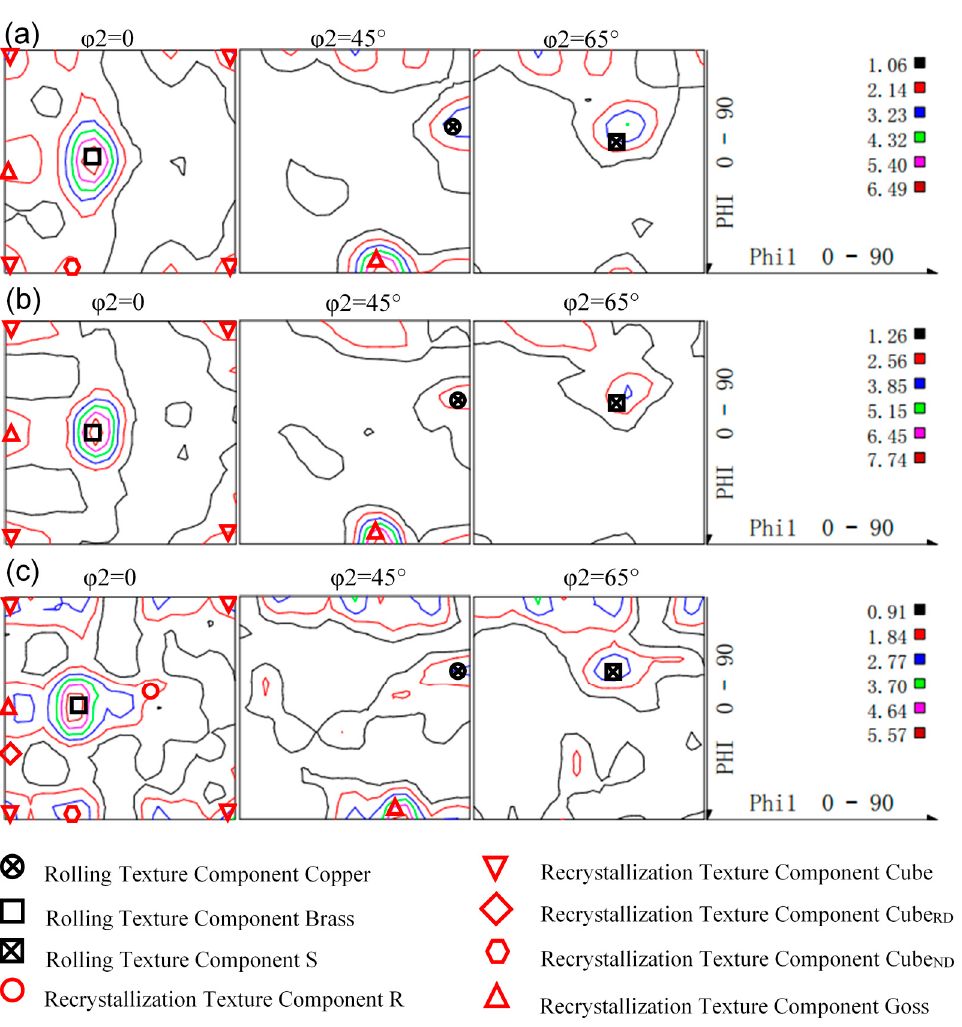
Figure 4. Orientation distribution function (ODF) images of 2195 Al-Li alloy sheets after isothermal annealing at different temperatures. ( a ) Cold ‐ rolled; ( b ) 300 °C; and ( c ) 400 °C.